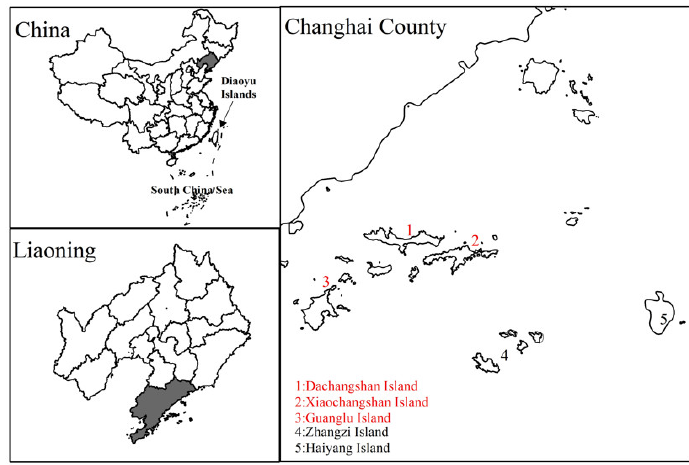
Figure 1. The location of the study area (Changhai County, China).